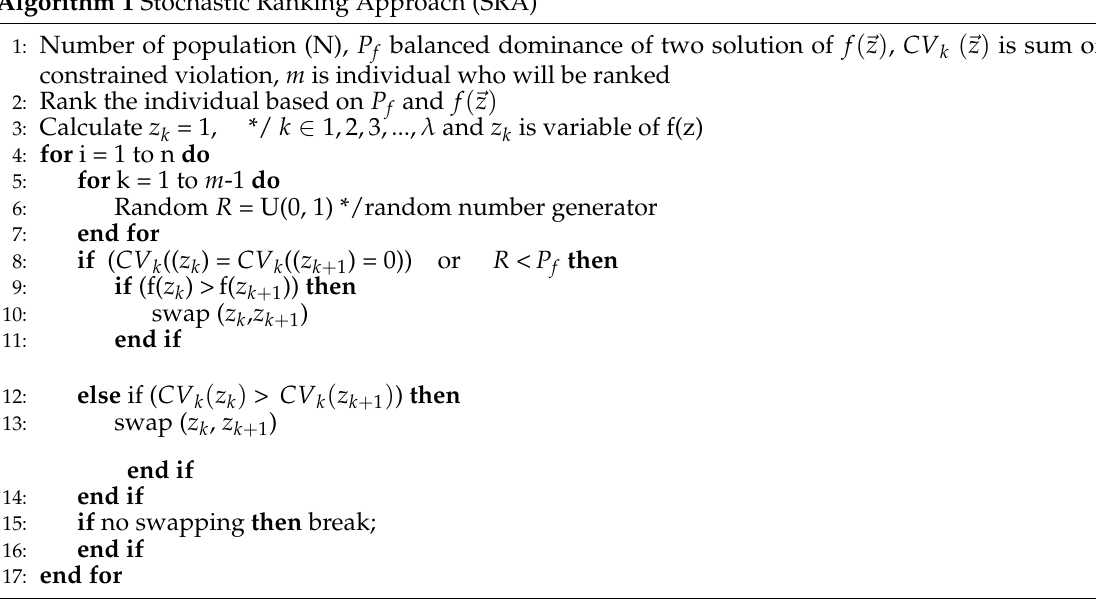
Algorithm 1 Stochastic Ranking Approach